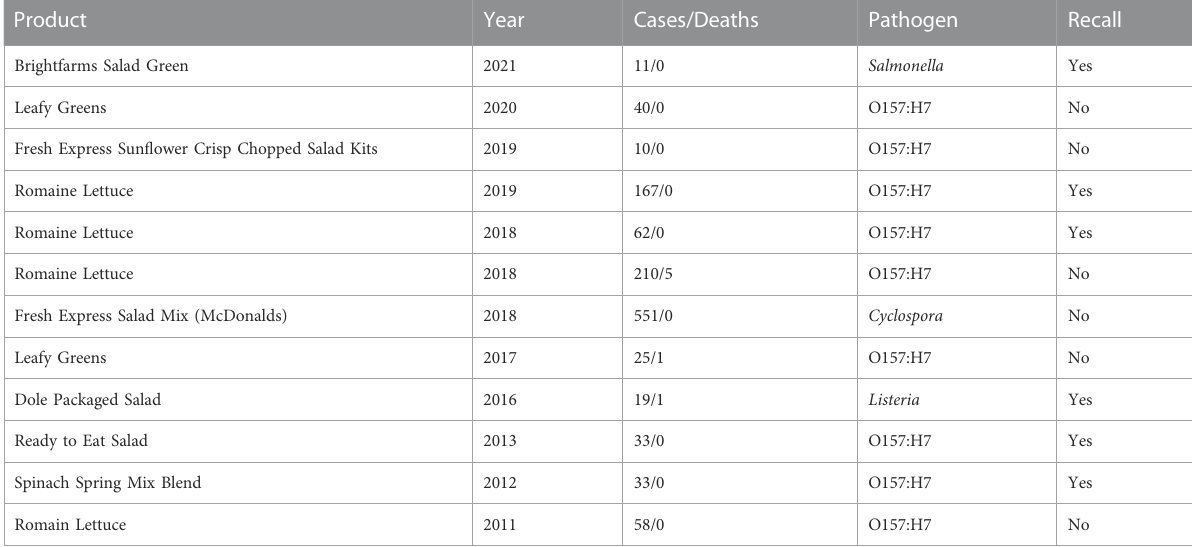
TABLE 1 CDC reported multistate outbreaks in leafy greens in the last 10 years (CDC, 2019).